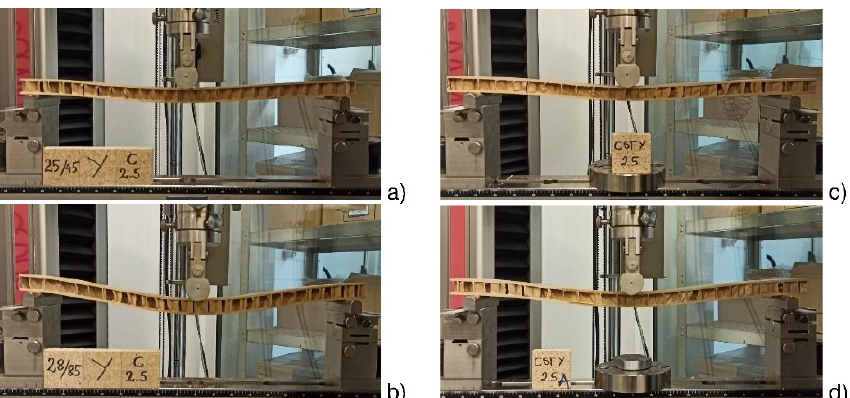
Figure 9. Illustration of the destruction of C-core cell plates: ( a ) CNH25YD beam ( b ) CNH25YW beam ( c ) CSH25YD beam ( d ) CSH25YW beam.